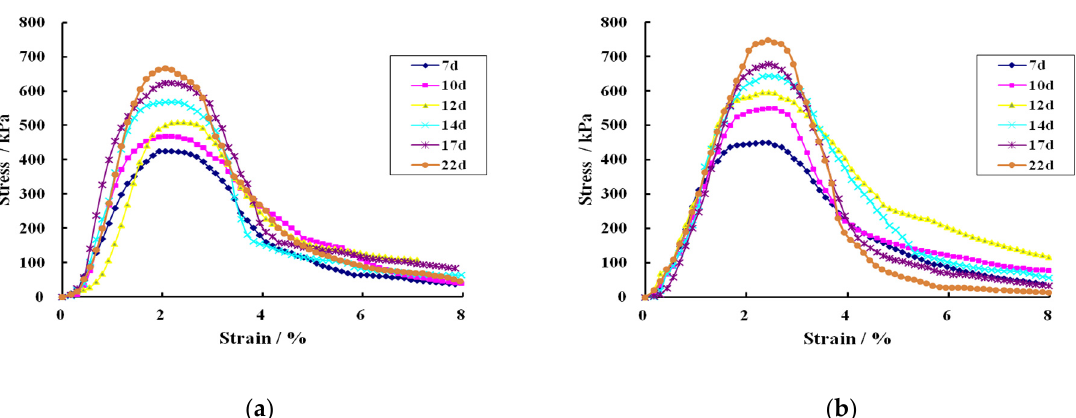
Figure 3. Stress–strain curves of OCC and PCC at room temperature. ( a ) Ordinary coastal cement clay (OCC); ( b ) polypropylene fiber-cemented clay (PCC).